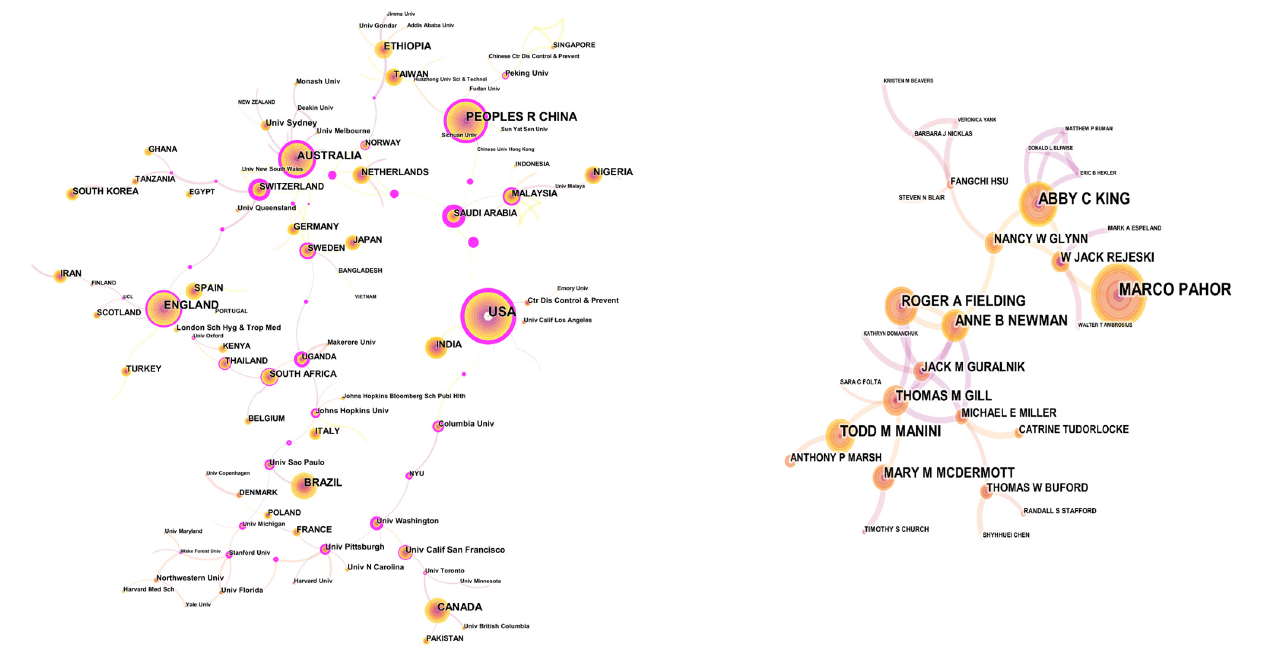
Figure 3. Co-authorship of HE research. The most representative author, co-institute, and country are Marco Pahor, Univ Sydney, and the USA. The size of the circle represents the number of studies published by the author, institutes, and countries. The shorter the distance between two circles, the more cooperation between the two authors. Purple rings indicate that these institutes have greater centrality (no less than 0.1).